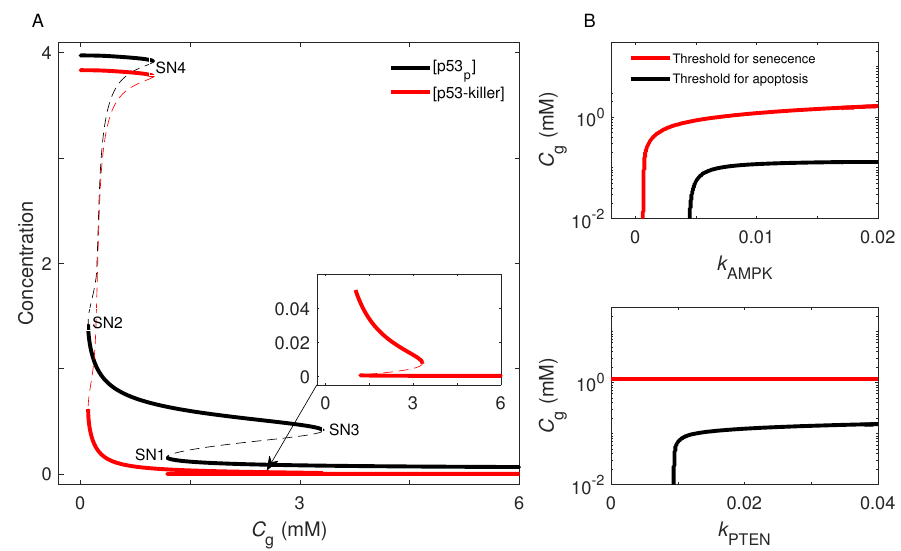
Figure 6. 6 Figure 6. Bistable switches underlying p53 dynamics. ( A ) Bifurcation diagrams for the levels of p53 p and p53-killer as a function of C g . The stable and unstable steady states are denoted by solid and dashed lines, respectively. The inset is an enlarged view of the diagram for [p53-killer]. ( B ) Dependence of the thresholds of C g for induction of apoptosis and senescence on the p53-inducible synthesis rates of AMPK and PTEN, k AMPK ( upper ) and k PTEN ( lower